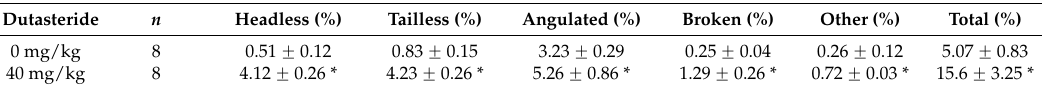
Table 2. Comparison of percentage abnormal cauda epididymis sperm (mean ± SEM) between the dutasteride-treated and control groups.